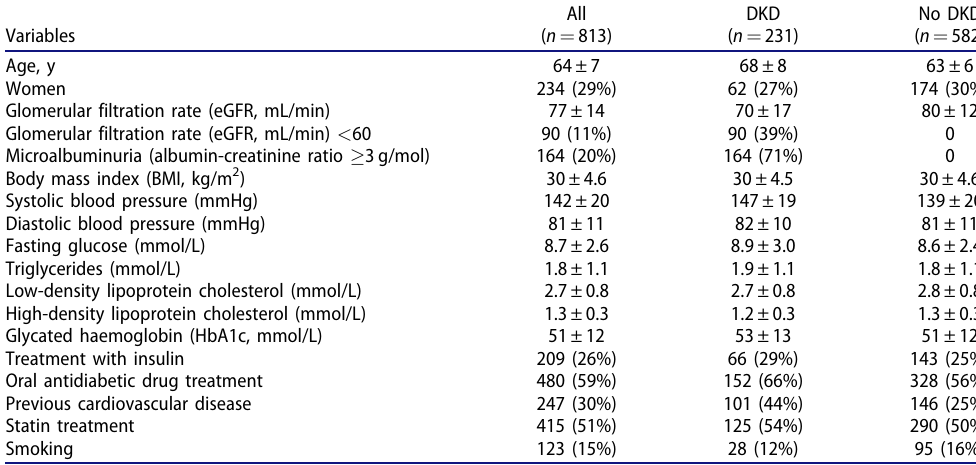
Table 1. Baseline